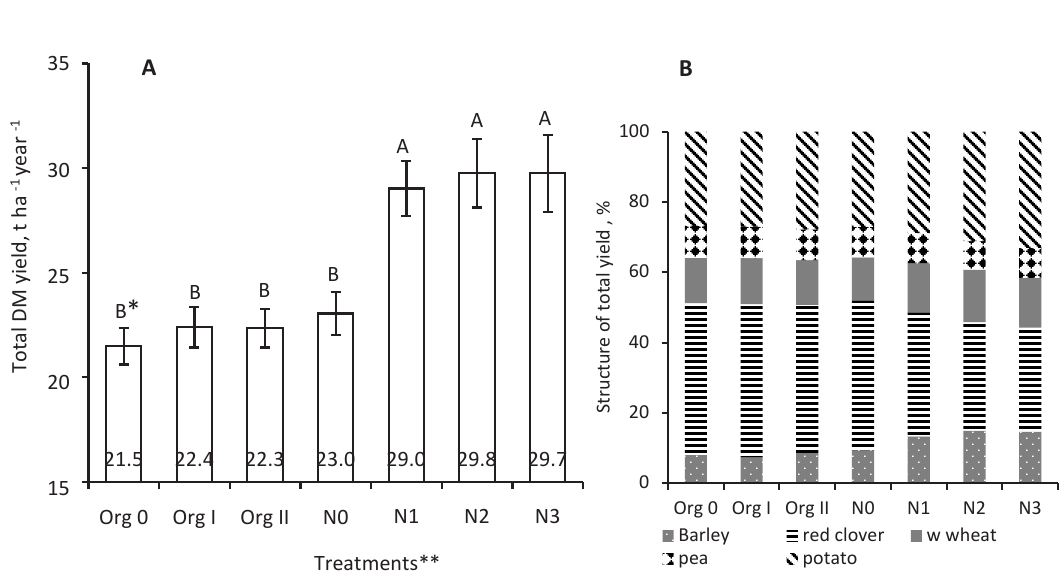
Fig. 1. Annual total yield of five crops (t ha ‒1 per year) in different treatments (A). Composition (%) of total yield of five crops in different treatments (B). F =9.271, p <0.001. * The means marked with the same letter do not differ statistically significantly (6, 63) from each other; **Org0 and N0 = control treatments of organic and conventional farming, respectively; OrgI = organic treatment with winter cover crops CC; OrgII = additionally to CC the well composted cattle manure applied; N1 = amounts of mineral NPK per ha: 40–50 kg N, 25 kg P, 95 kg K; N2 = amounts of mineral NPK per ha: 80–100 kg N, 25 kg P, 95 kg K; N3 = amounts of mineral NPK per ha: 120–150 kg N, 25 kg P, 95 kg K. Less mineral N fertilisers were applied to barley undersown with red clover.